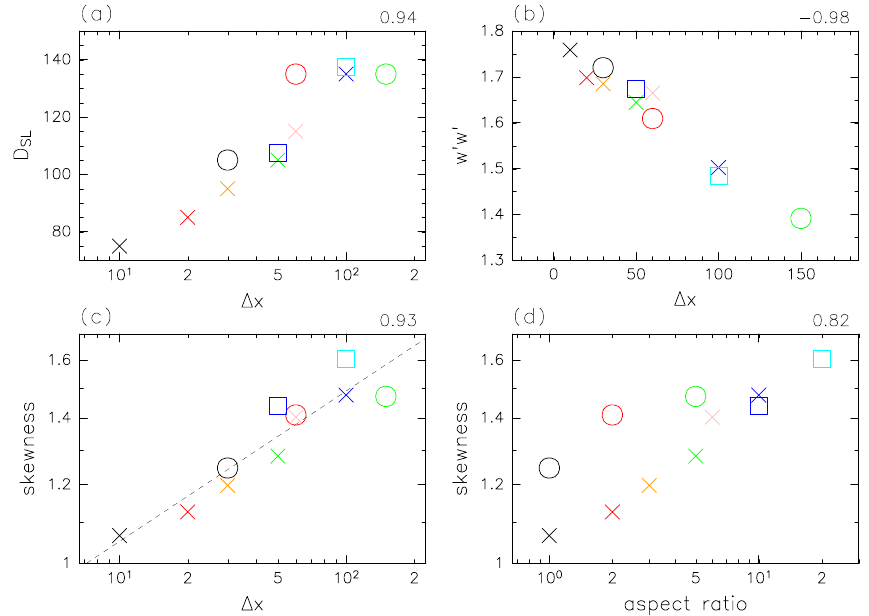
Figure 6. Scatter diagrams between some quantities and grid configurations: (a) depth of surface layer vs. horizontal grid spacing, (b) vari- ance of vertical velocity at 500m height vs. horizontal grid spacing, (c) skewness of vertical velocity at 1200m height vs. horizontal grid spacing, and (d) skewness vs. grid aspect ratio in the control experiment. Colors and symbols represent grid aspect ratio and vertical res- olution, respectively, as in Fig. 4: 1 (black), 2 (red), 3 (orange), 5 (green), 6 (pink), 10 (blue), and 20 (cyan). Squares, crosses, and circles indicate 5, 10, and 30m, respectively. Value at top right of each diagram is the correlation coefficient. Note that the coefficient is calculated with the logarithm of skewness, horizontal grid spacing, and aspect ratio in (c, d) . The broken line in (c) represents the regression line.